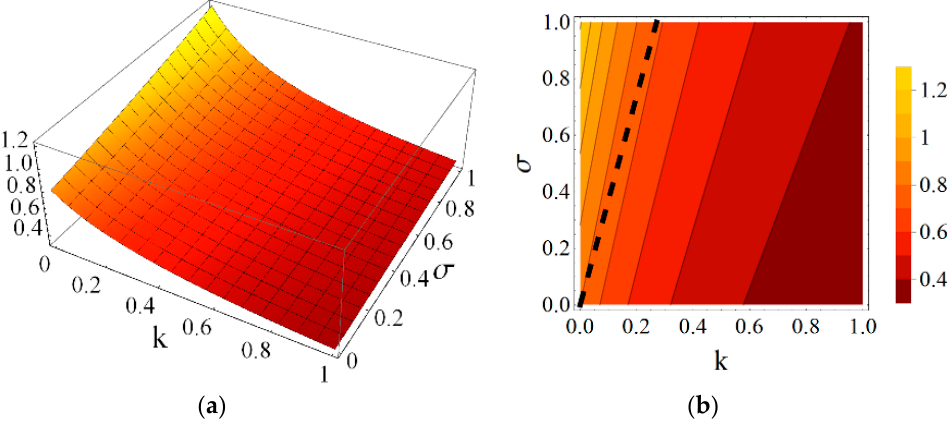
( a ) ( b ) νν = : ( a ) 3D plot; and ( b ) contour plot. Figure 11. Poisson’s ratio Figure 11. Poisson’s ratio ν 31 = ν 32 : ( a ) 3D plot; and ( b ) contour 3231